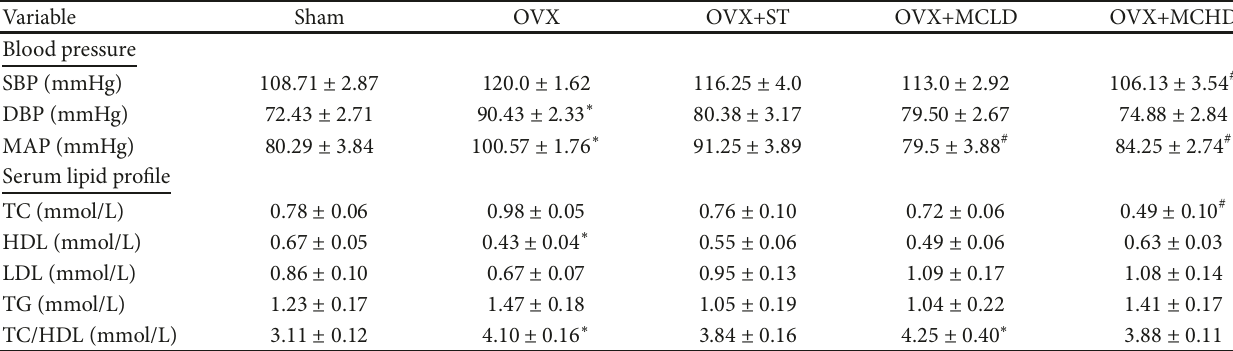
Table 1: Evaluation of blood pressure and serum lipid profile following MC treatment.